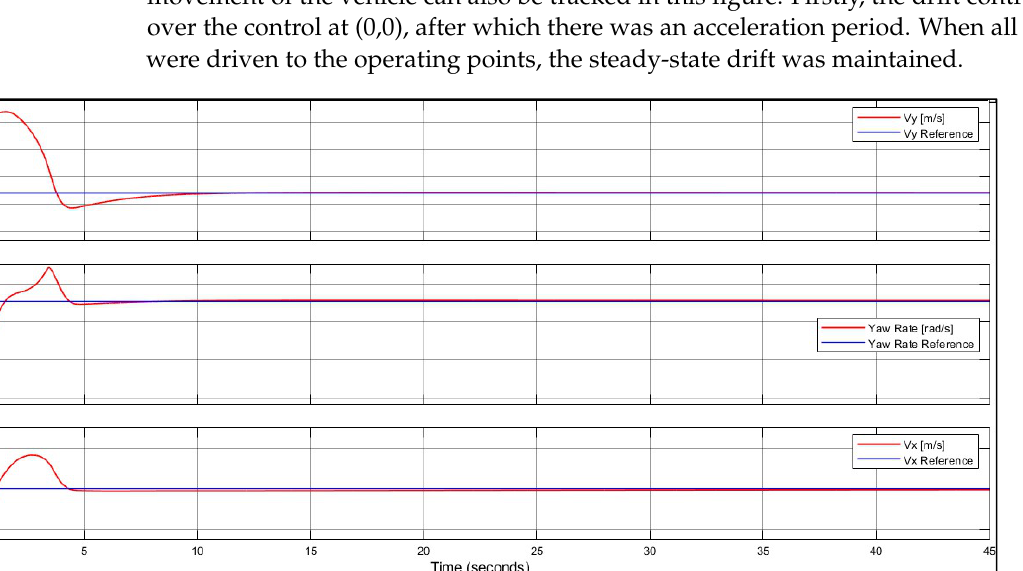
Figure 7. Drift scenario around equilibrium Case No. 1.